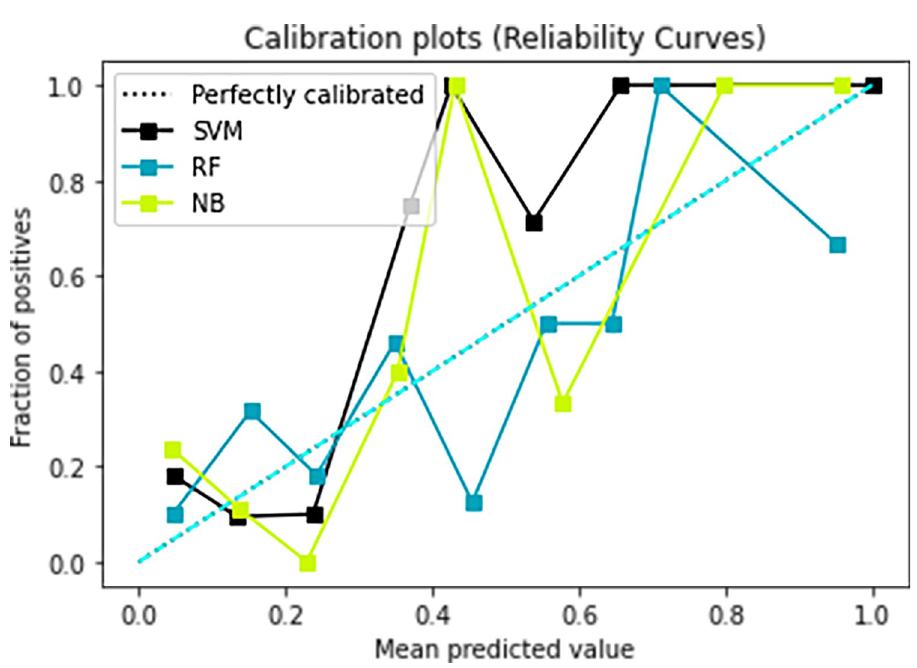
Fig 9. Calibration plots of the three candidate models for the prognosis of IgAN with ’Crescent proportion’ and ’Global crescent proportion’.